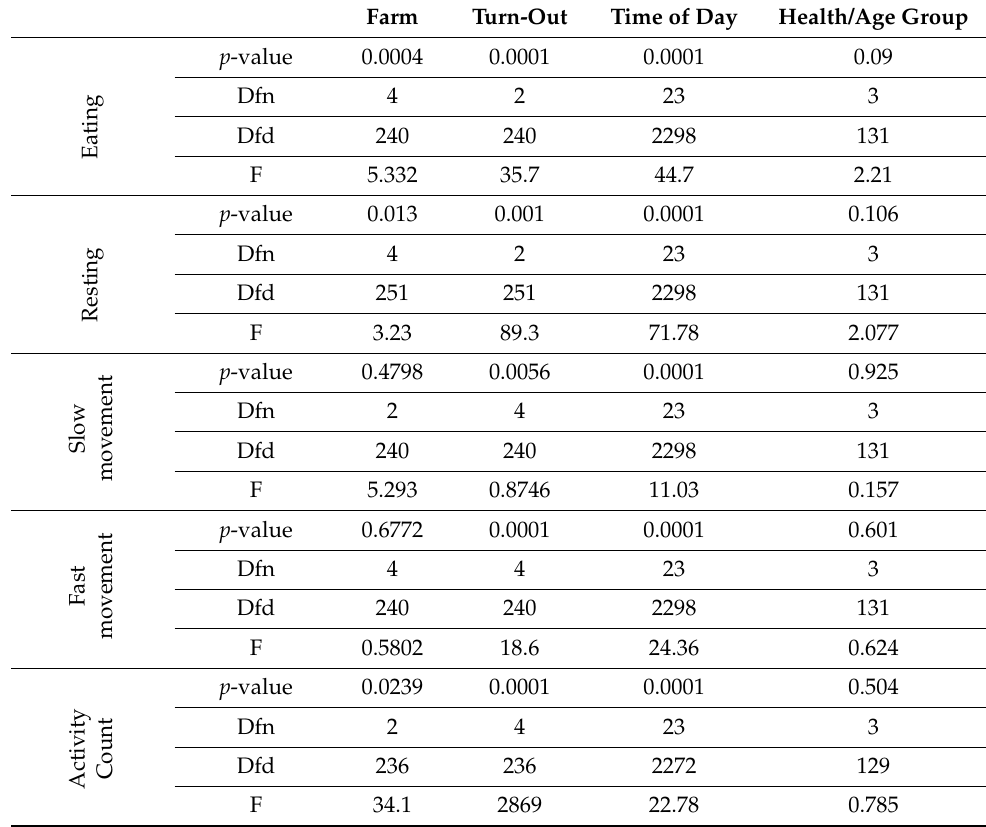
Table 4. Results of ANOVA: p -values, Dfn, Dfd and F values for the comparison by farm, turn-out condition, time of day and health/age group are listed for all time budgets and the activity